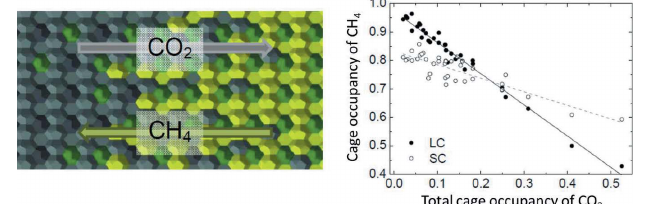
Figure 4 Evolution of selected atomic parameters refined against neutron powder diffraction data collected during the stepwise dosing of Cu 3 (cdm) 4 with